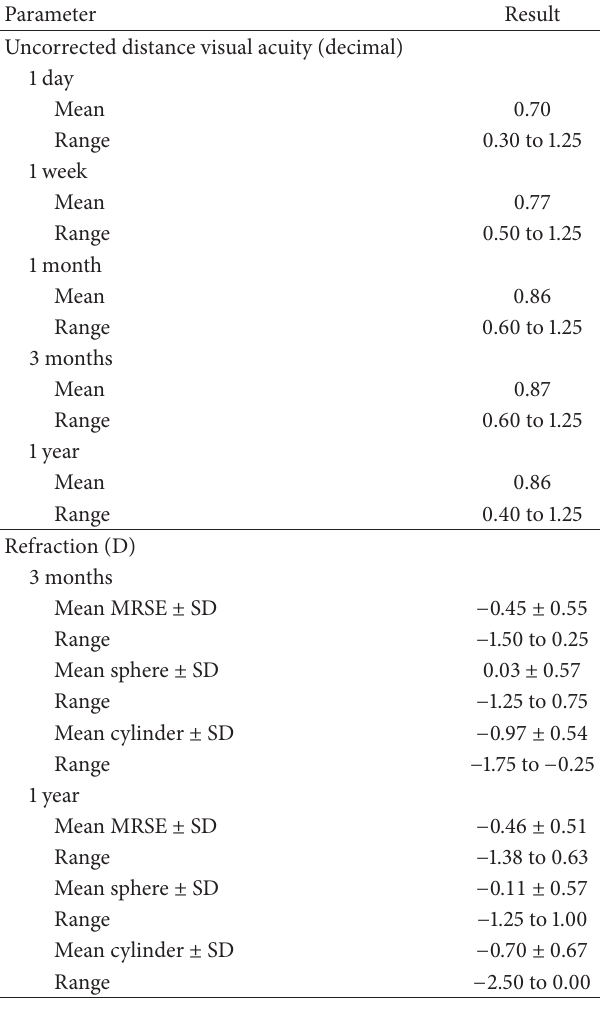
Table 2: Postoperative visual outcomes.